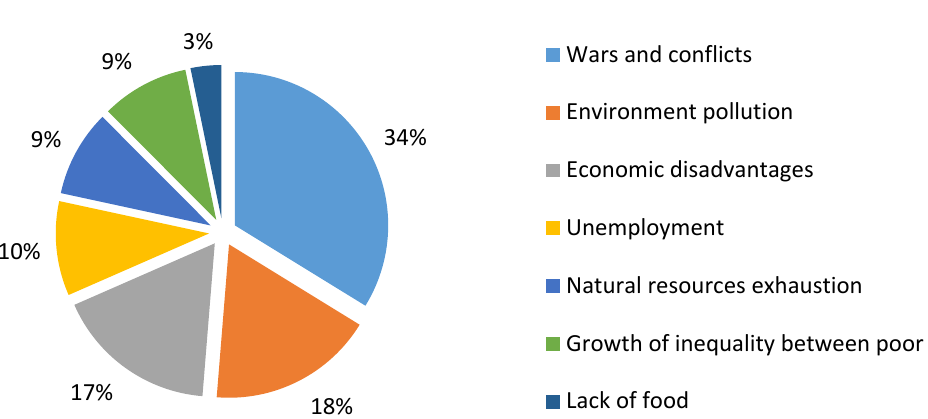
Figure 1. Detection of global threats for future generations: answers of Ukrainians in